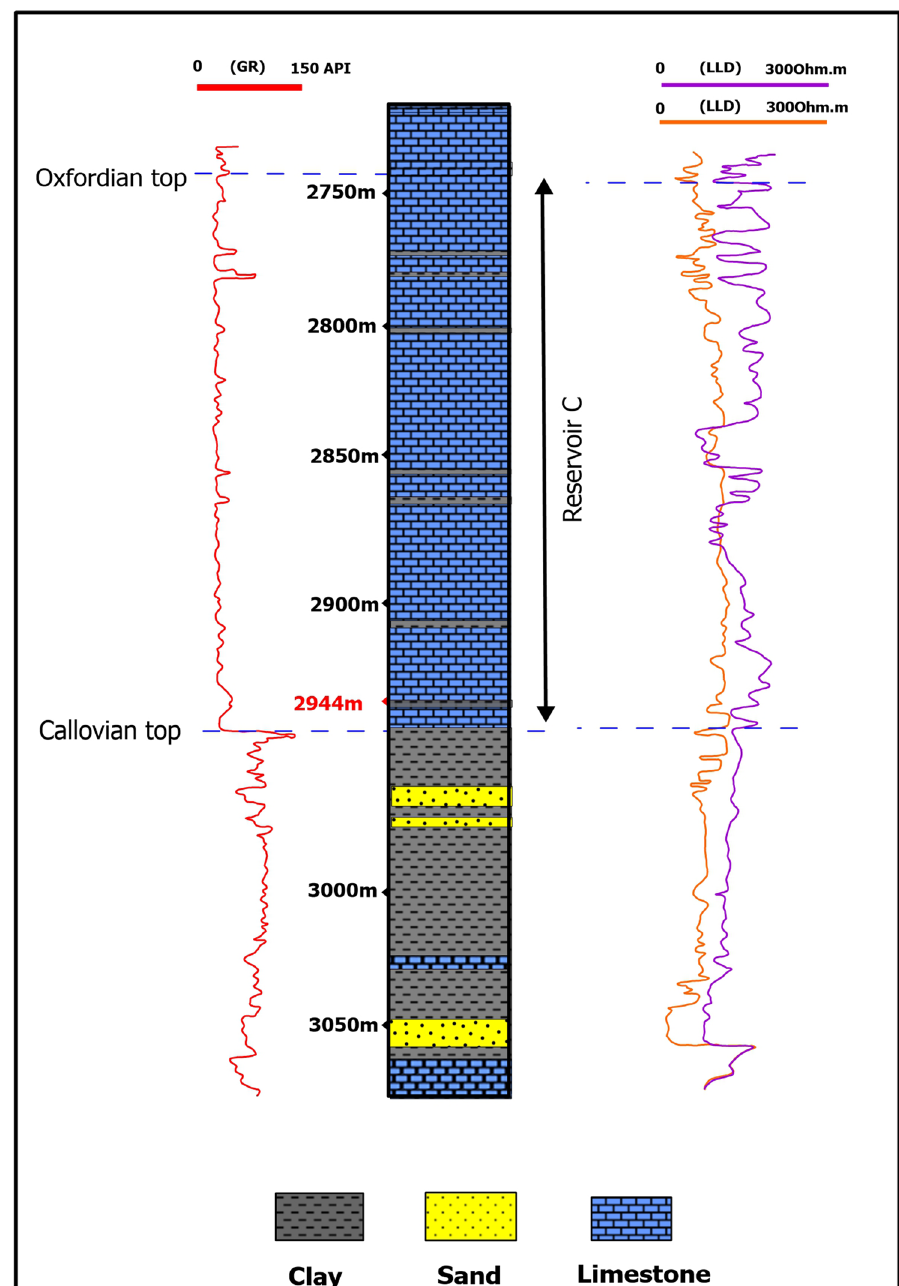
Fig. 8 Characterization of